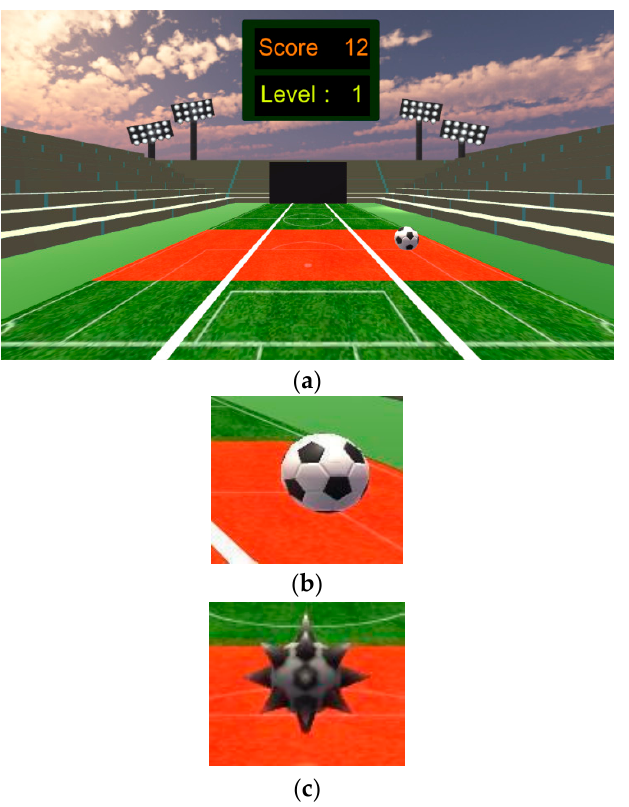
Figure 2. Screen shots of the first stage of the hit-the-ball game: ( a ) the scene, ( b ) the ball, and ( c ) the metal meteor.